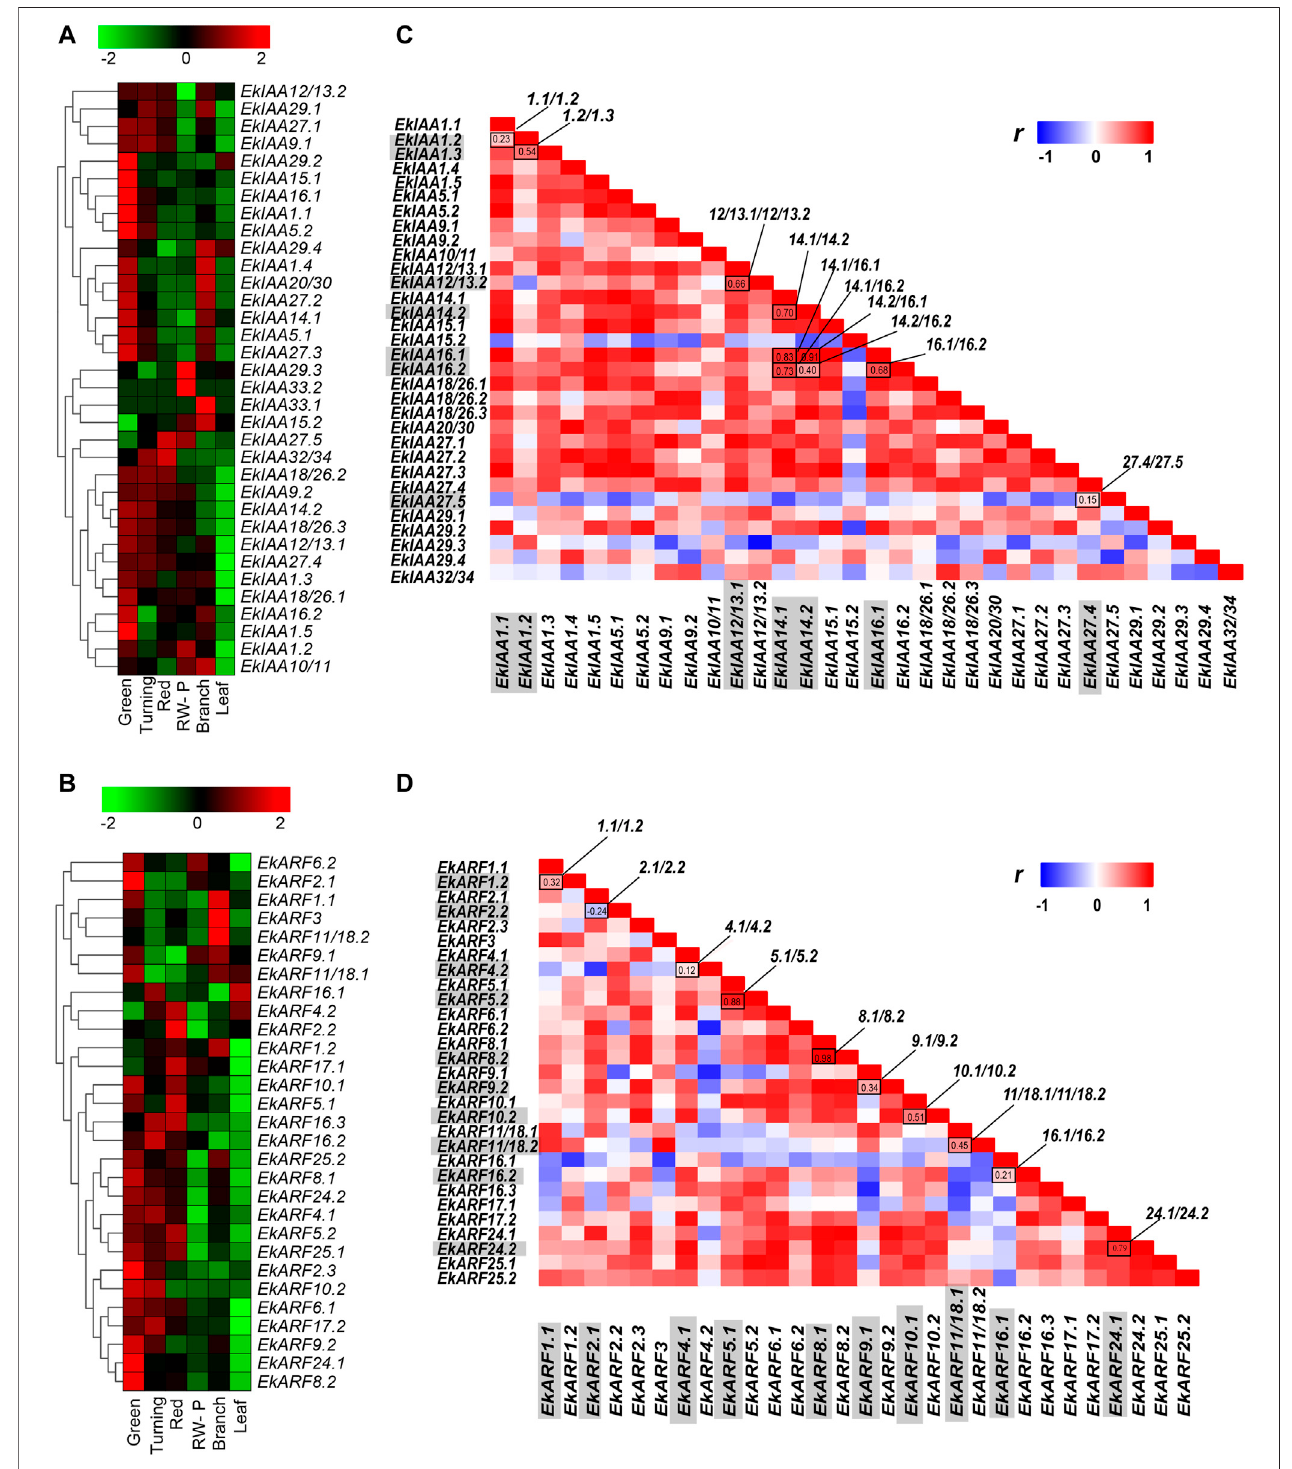
FIGURE 6 | Heatmap representation of the expression of EkIAA (A) and EkARF (B) genes during fruit developmental stages (green, turning, red fruit, and red- winged pericarp) in branches and leaves. The color bar indicates Log 2 -normalized transcripts per million reads (TPM). RW-P, red-winged pericarp.